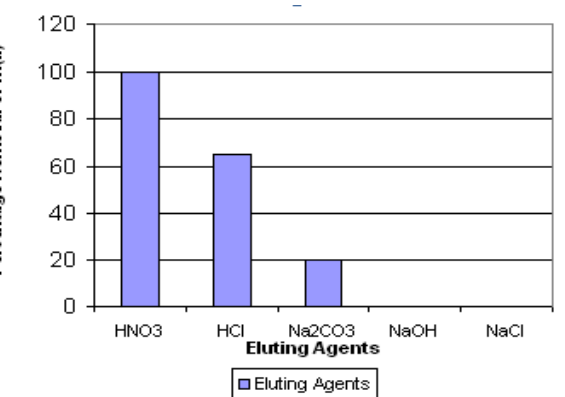
Figure 8: Effect of different eluting agents on desorption of Ni(II) Adsorption